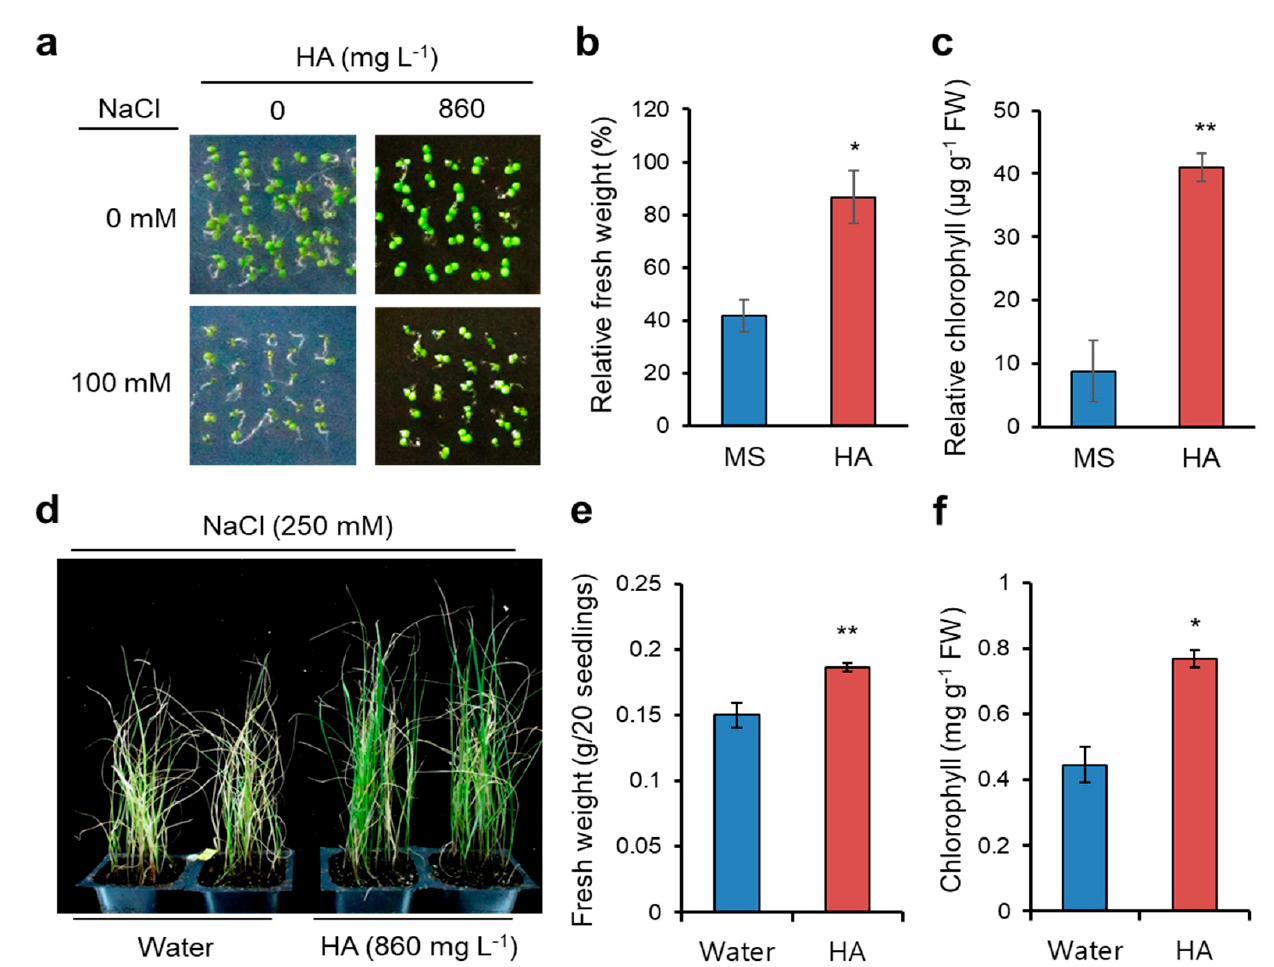
Figure 1. Humic acid (HA) confers salt stress tolerance in Arabidopsis and Italian ryegrass. ( a – c ) HA-induced salt stress tolerance in Arabidopsis. ( a ) Pictures shown 7-d-old wild-type Arabidopsis (Col-0) seedlings grown in 1/2 Murashige and Skoog (MS) media or that containing 860 mg L − 1 HA supplemented with or without 100 mM NaCl for 7 d. ( b ) Relative fresh weight and ( c ) relative chlorophyll content (in the presence vs. absence of 100 mM NaCl). Fresh weight and chlorophyll contents were measured and relatively calculated (salt-treated values divided by non-treated). Data represent means ± SE, n = 3. * p < 0.05, ** p < 0.01 compared with seedlings grown in MS media. ( d – f ) HA-induced salt tolerance in Italian ryegrass. ( d ) Picture shown 20-d old Italian ryegrass seedlings exposed to 250 mM NaCl for 10 d with foliar application of water or HA (860 mg L − 1 ) by spray. ( e ) Fresh weight and ( f ) chlorophyll contents were measured. Data represent means ± SE, n = 3. * p < 0.05, ** p < 0.01 compared with seedlings sprayed with